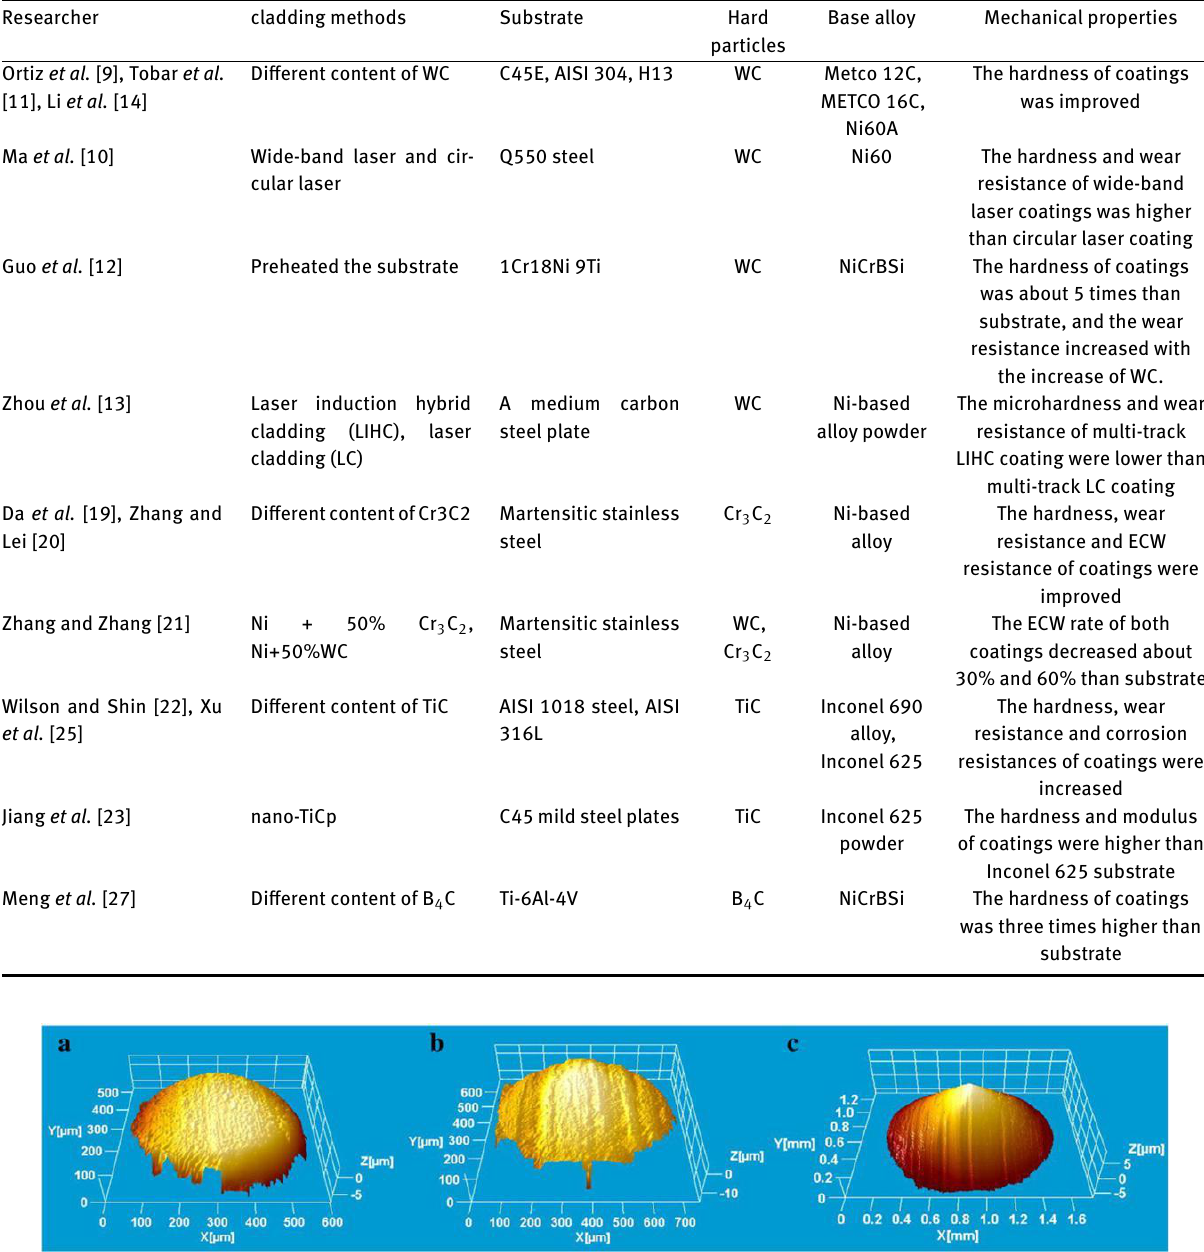
Table 1: The coatings reinforced by hard particles with direct addition method